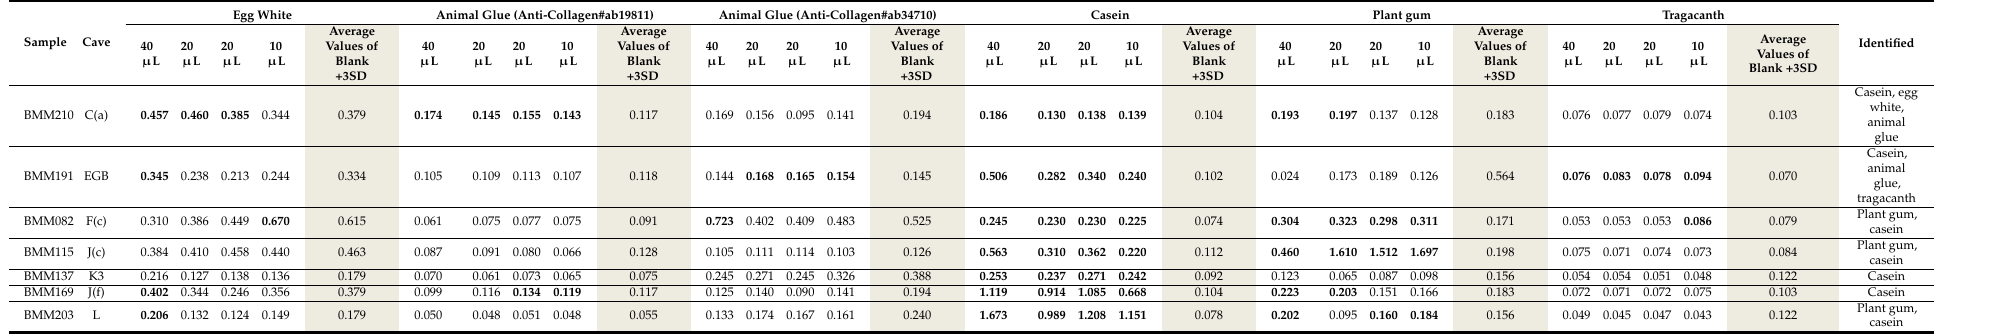
Table 6. ELISA optical densities for